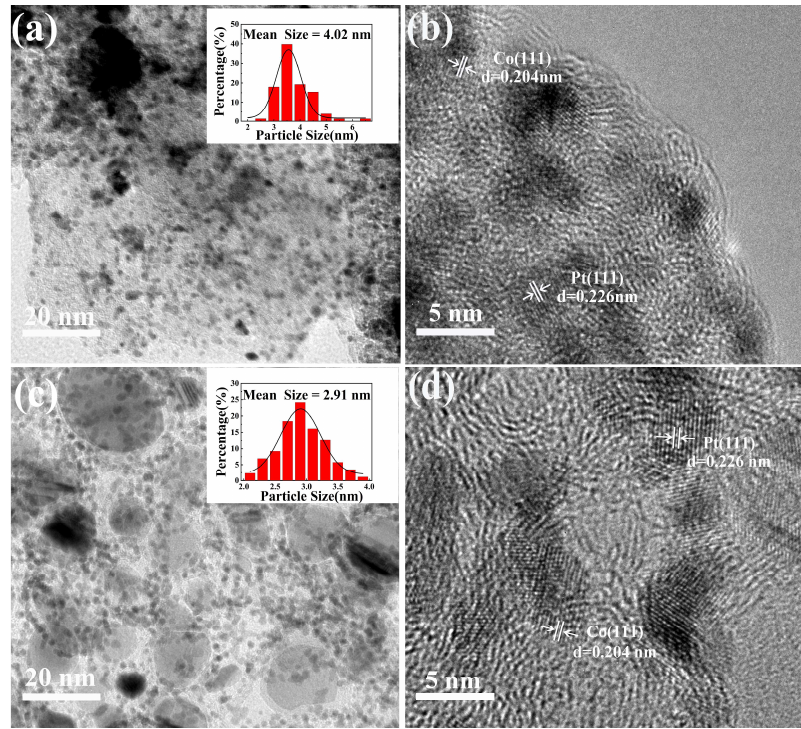
Figure 8. HRTEM images of ( a , b ) Pt/Co-PC800; ( c , d ) Pt/Co-NCNT-HPC800. To investigate the electrochemical performance of Pt/Co-NCNT-HPC800, adopt DMFC as the model system, comparing with Pt/C (20%), Pt/Co-PC800, Pt/Co-NCNT- HPC600, Pt/Co-NCNT-HPC700 and Pt/Co-NCNT-HPC900 (Figure 9). The CV curves in 0.5 mol L − 1 H 2 SO 4 of catalysts are shown in Figure 9a, indicating the expected behav- ior of Pt electrodes in the H 2 SO 4 solution. The area of the electrode in which electrons are exchanged at the electrode is called the active area, or electrochemical surface area (ECSA), which provides an understanding of the number of active sites. The results of ECSA are derived from the equation ECSA = Q H /(0.21 · L Pt ), with 0.21 (mC · cm − 2 ) as the charge required to oxidize a monolayer of hydrogen, L Pt (mg · cm − 2 ) representing the Pt load on the working electrode and Q H (mC · cm − 2 ) representing the charge-exchanged during electro-desorption of hydrogen. The ECSA results are reflective of the intrinsic activity of the composite catalyst [50]. The calculated ECSA of Pt/Co-PC800, Pt/Co-NCNT- HPC600, Pt/Co-NCNT-HPC700, Pt/Co-NCNT-HPC800, and Pt/Co-NCNT-HPC900 are 38.52 m 2 g − 1 , 41.0 m 2 g − 1 , 43.0 m 2 g − 1 , 49.7 m 2 g − 1 and 45.8 m 2 g − 1 , respectively, which are larger than 20% Pt/C (27.0 m 2 g − 1 ) and Pt/Co-PC800 (38.5 m 2 g − 1 ). Apparently, from the H ad peak areas of all catalysts, the peak areas of catalysts supported on Co-NCNT-HPC are larger than those of other catalysts, indicating that the catalysts by nitrogen doping and hollow porous possess a larger ECSA. The maximum ECSA value of Pt/Co-NCNT- HPC800 indicates the electrochemically active surface area of a series of Pt/Co-NCNT-HPC catalysts can be increased by appropriate pyrolysis temperature. The highest ECSA value of Pt/Co-NCNT-HPC800 composite catalyst can be responsible for the small particle size and well dispersion of Pt atoms on the support, as well as a large number of CNTs with good internal channels, which can facilitate the transport of electrons and become more conducive to the exposure of more active